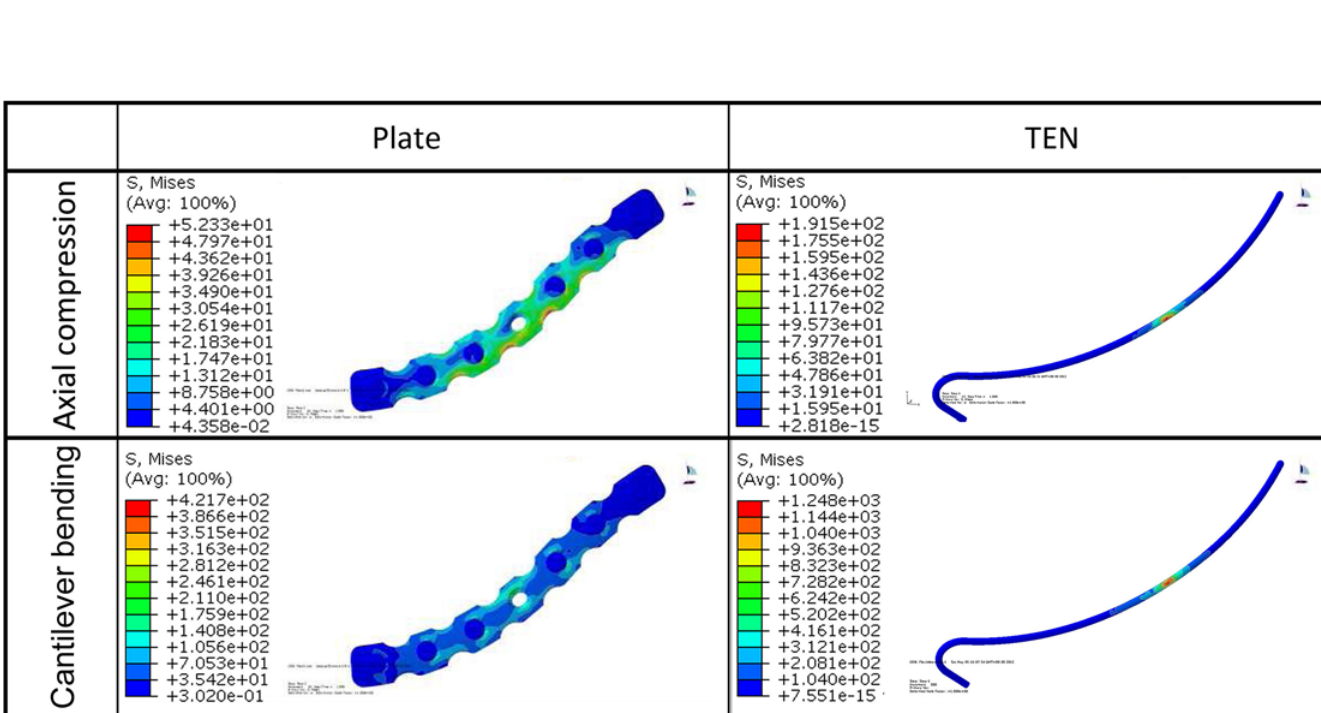
PLOS ONE | DOI:10.1371/journal.pone.0126131 May 12,